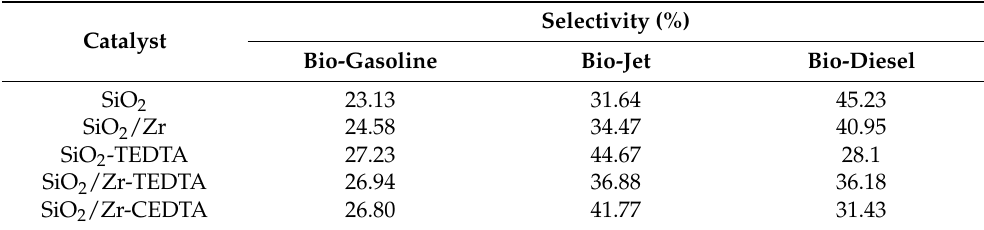
Table 5. Biofuel product selectivity from CPO hydrocracking over various